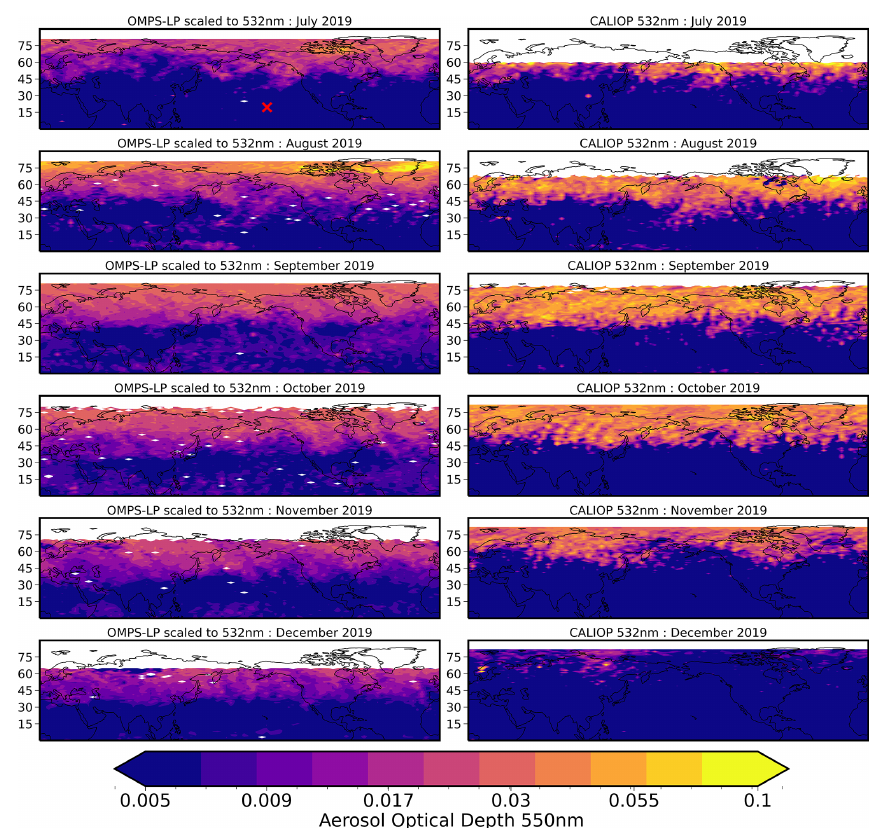
Figure 6. Monthly geographic evolution of the Northern Hemisphere sAOD from July 2019 to December 2019 derived from OMPS-LP retrieved aerosol extinction (left) and CALIOP aerosol extinction profile (right). We remove the long-term background sAOD derived from OMPS-LP and CALIOP for the years 2013–2018 from those for 2019 to provide a stratospheric perturbation for the